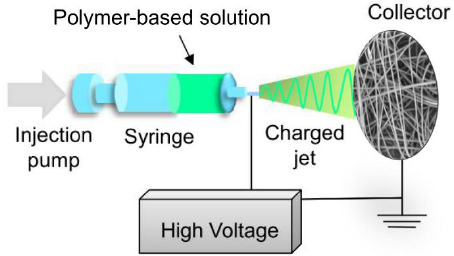
Figure 2. Schematic illustration of the fiber production via electrospinning.